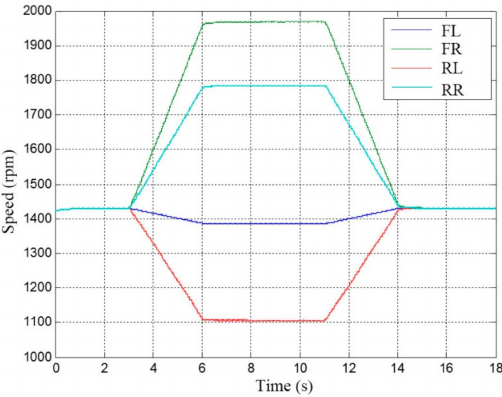
Figure 16. The SRM speed at 30 ◦ with heavy load.